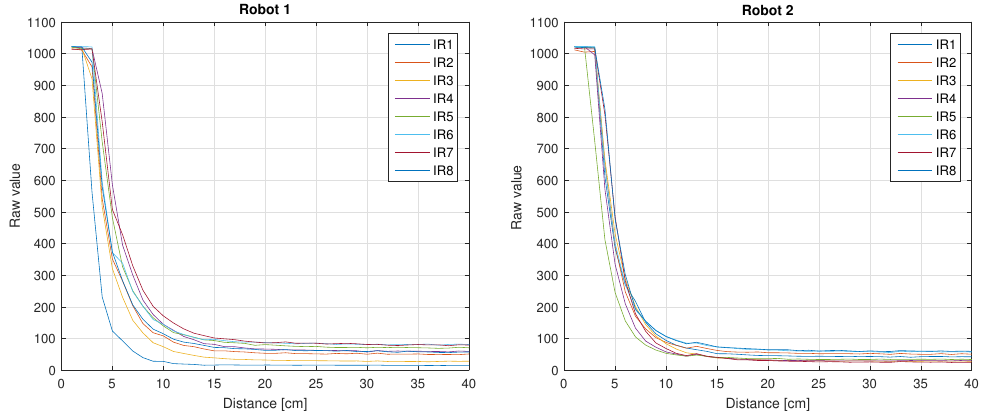
Figure 4. Robots 1 and 2 IR sensors values vs.